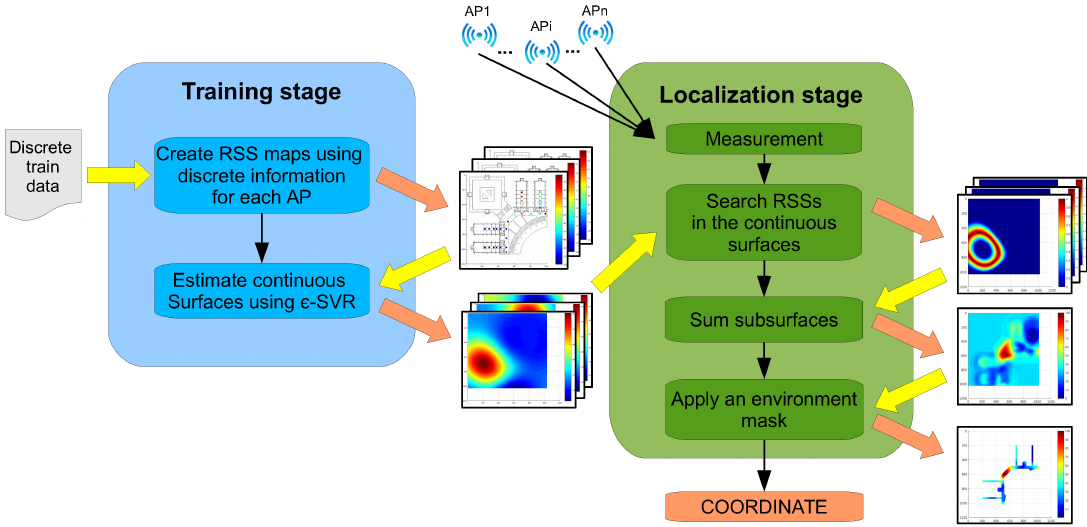
Figure 1. General architecture of the